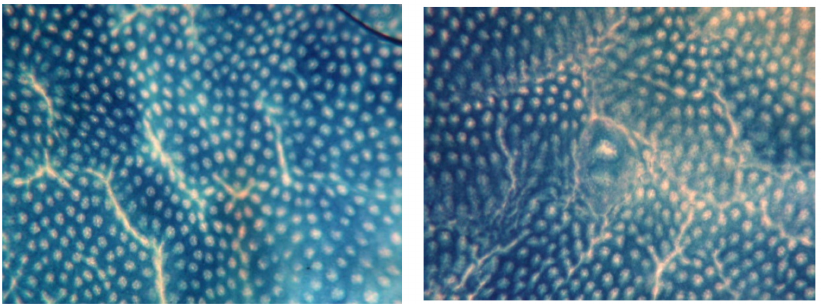
Figure 4. Methylene blue stain of the distal colon ( left ) normal crypt, ( right ) aberrant crypt foci (magnification 100 × ).